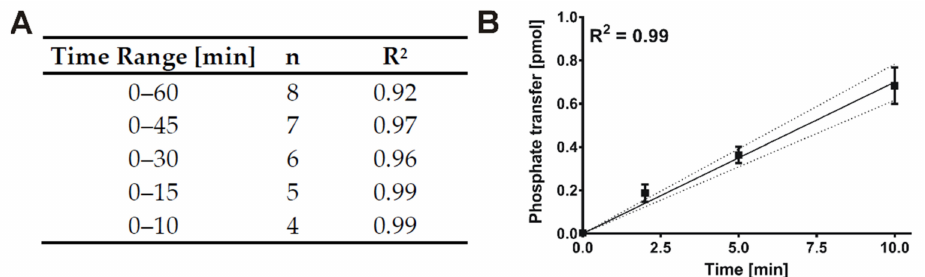
Figure 4. Determination of initial velocity linear region for GST-CK1 δ . ( A ) In order to determine the maximum coefficient of determination (R 2 ) linear regression analysis was conducted with stepwise decreasing the number of included time points of the product-over-time progression curve deter- mined for GST-CK1 δ (7 nM). ( B ) Linear regression for the determined initial velocity region (10 min) including R 2 value and confidence bands (95%). n, sample size; R 2 , coefficient of